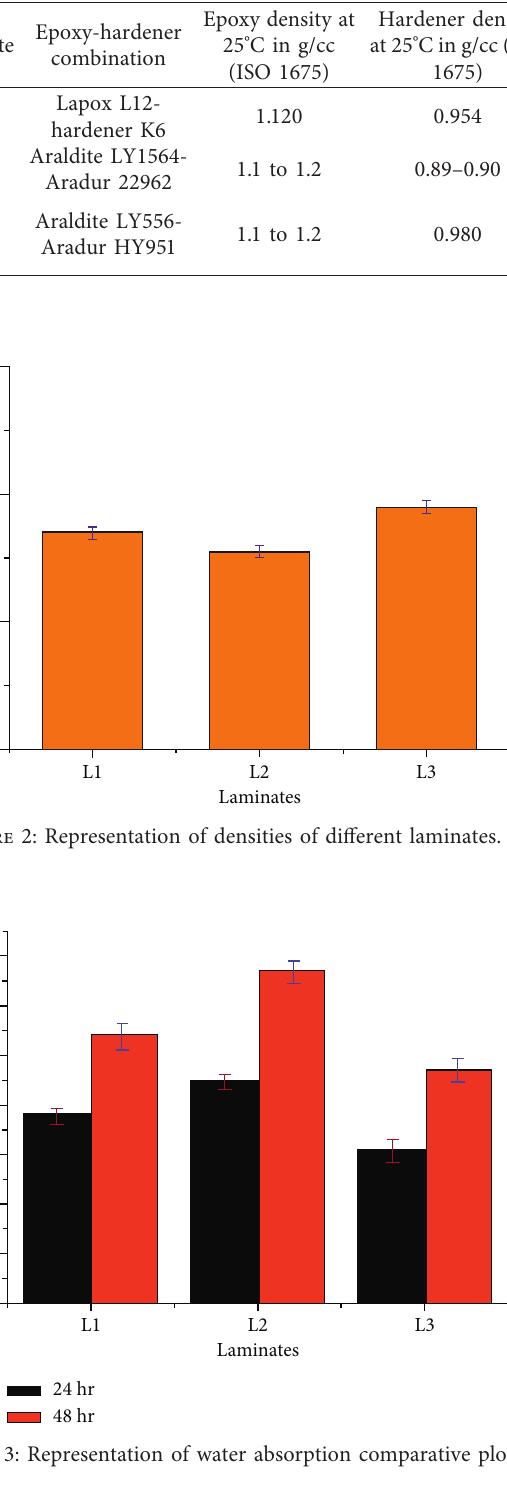
Table 2: Properties of different epoxy-hardener combinations.